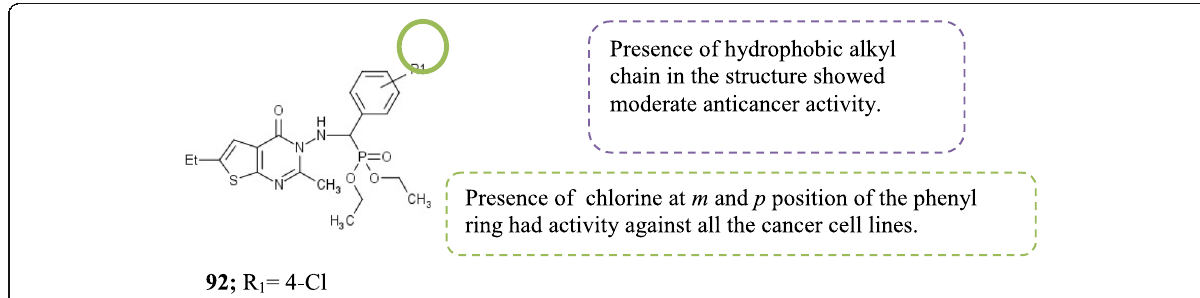
Fig. 32 SAR studies and chemical structures of thieno [2, 3-d] pyrimidines having